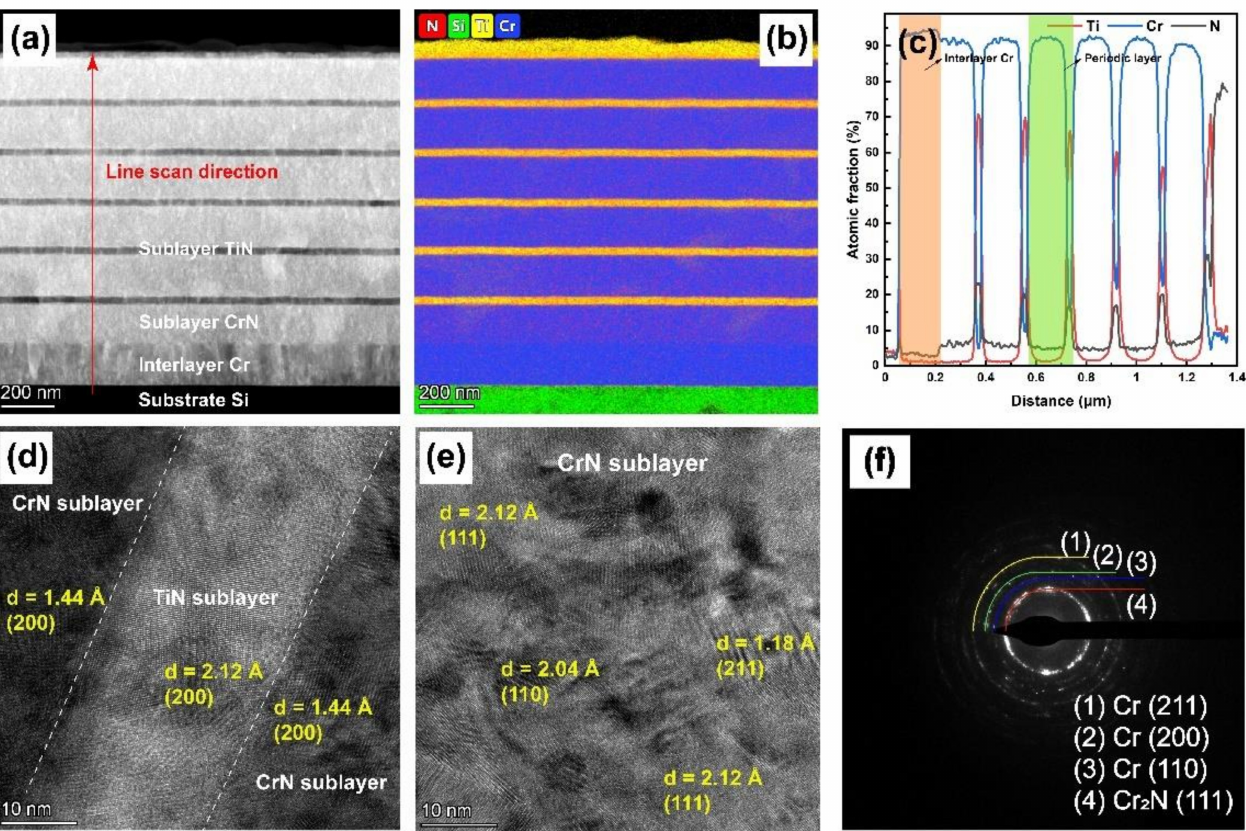
Figure 8. Cross-sectional TEM micrographs ( a ), elemental mapping ( b ), line sweep ( c ), high- magnification of interface ( d ) and Cr 2 N sublayer ( e ) and selected area diffraction patterns ( f